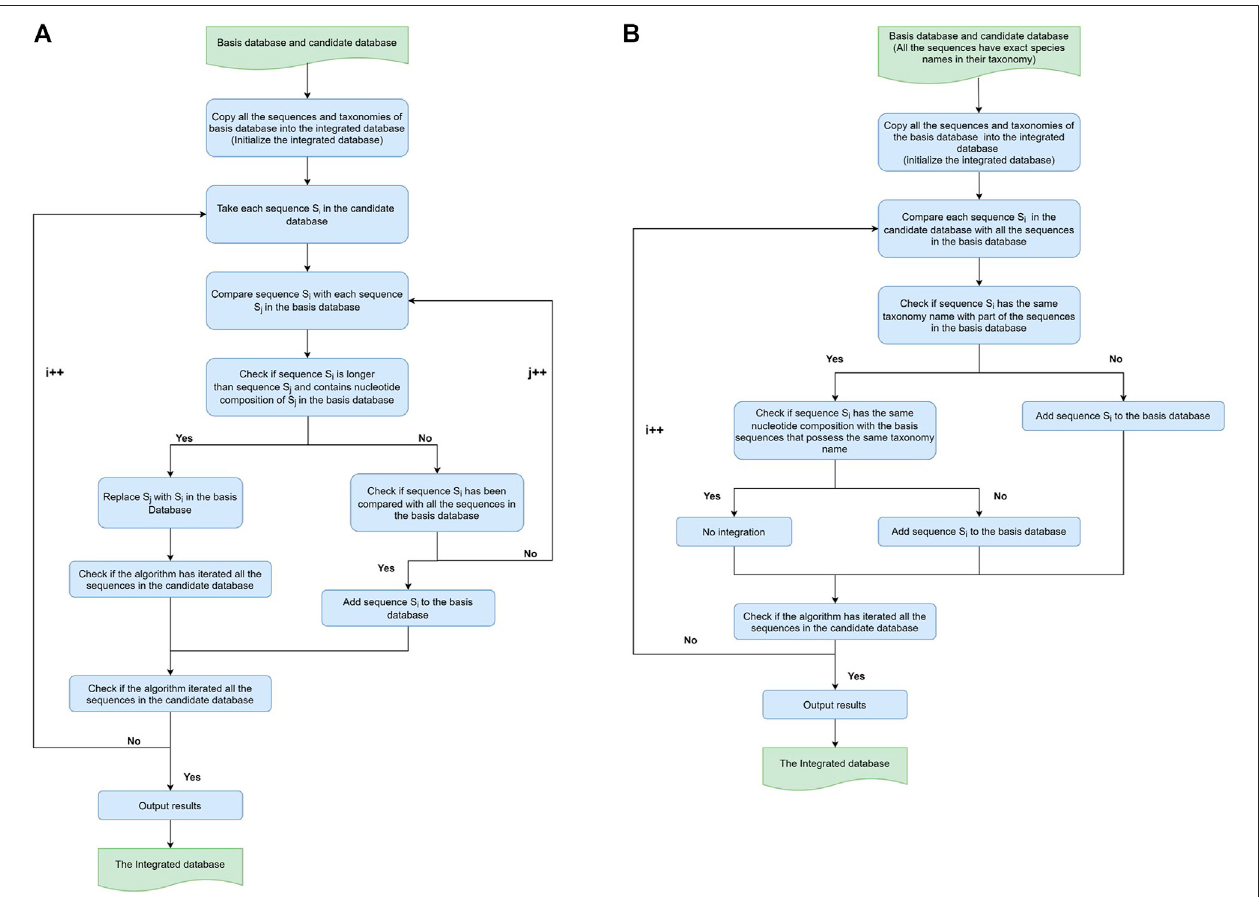
FIGURE 1 | Work fl ow of sequence-based and taxonomy-based Integration. (A) Sequence-based integration and (B) taxonomy-based integration. For both sequence-basedintegrationandtaxonomy-basedintegrationwork fl ows,thealgorithmtookRDPasthebasisdatabaseandSILVAasthecandidatedatabaseinthe fi rst roundtoproducetheintermediateRS-ITGDB.Then,thealgorithmtookRS-ITGDB(newbasis)andGreengenes(newcandidate)asinputstorunthiswork fl owagainand produce the fi nal integrated